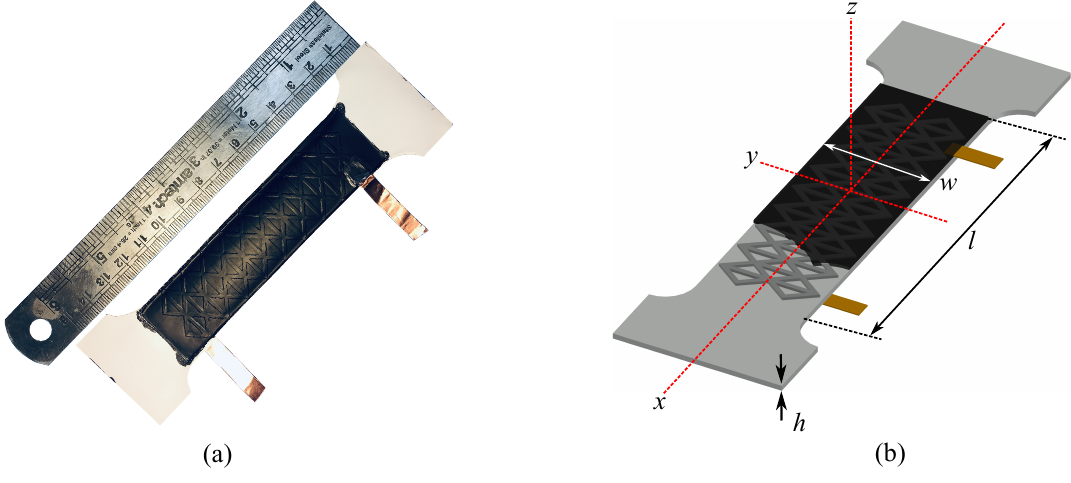
Figure 1. ( a ) Picture of a textured soft elastomeric capacitor (SEC) and ( b ) a schematic of a corresponding SEC of thickness h and a section of the electrode layer with electrode area l × w (black